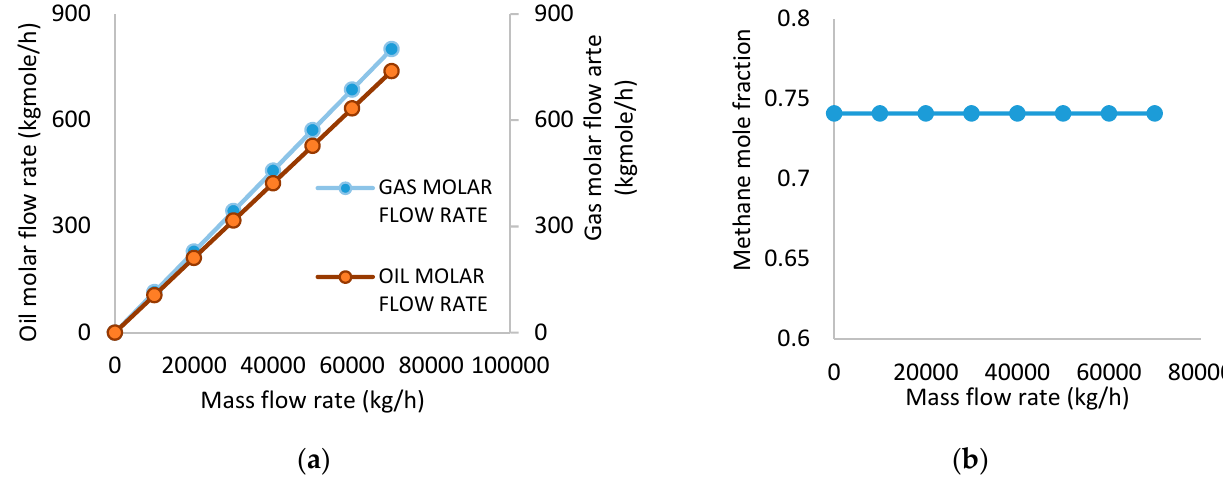
Figure 4. ( a ) Effect of inlet mass flow rate on gas molar flow rate and oil molar flow rate. ( b ) Effect of inlet mass flow rate on methane mole fraction.